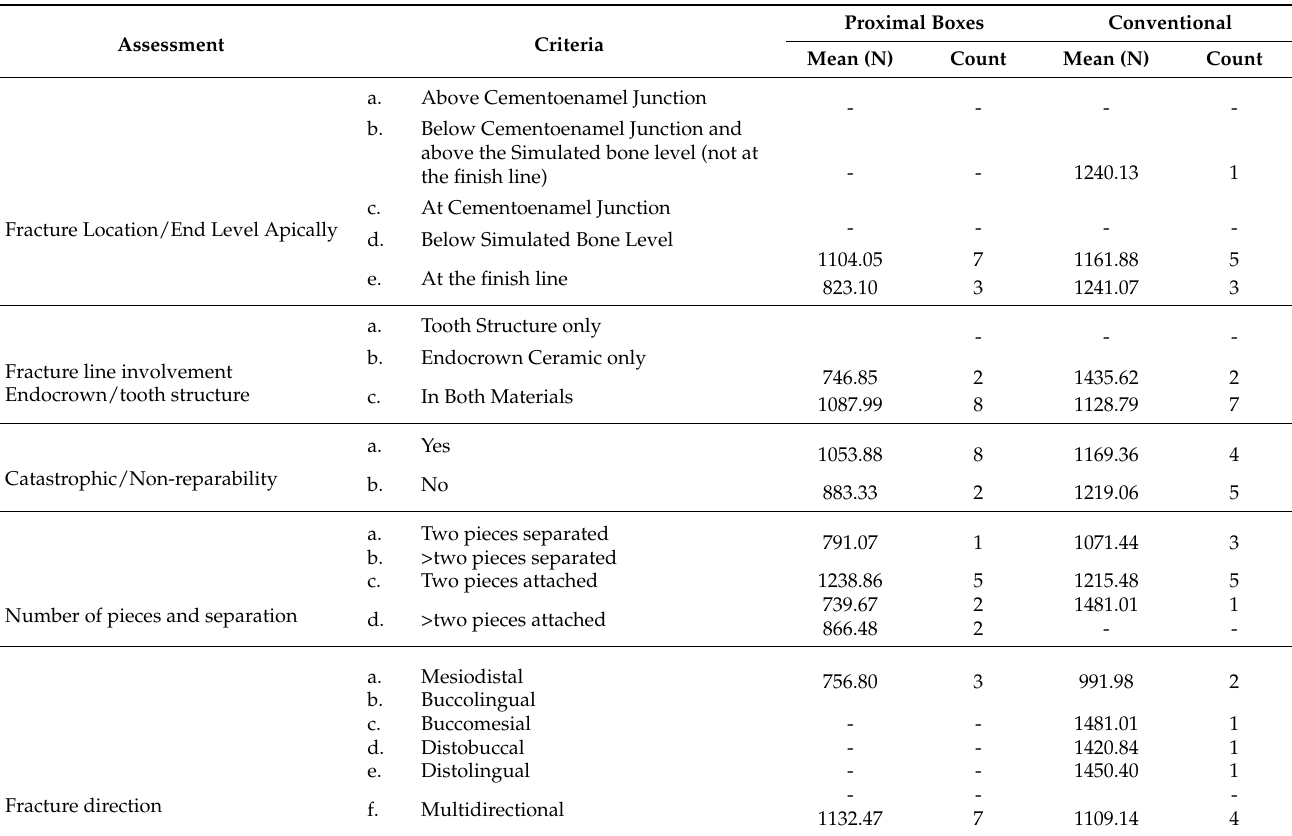
Table 3. Comparison between the conventional and the proximal boxes extension groups of each examined (observed) item and the number of specimens after